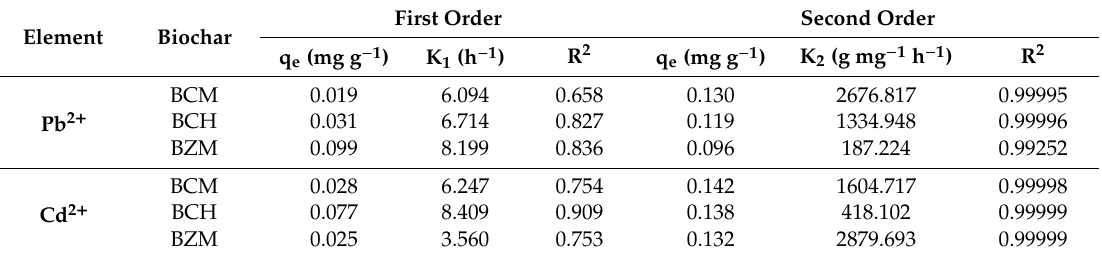
Table 4. Parameters of mathematical kinetic